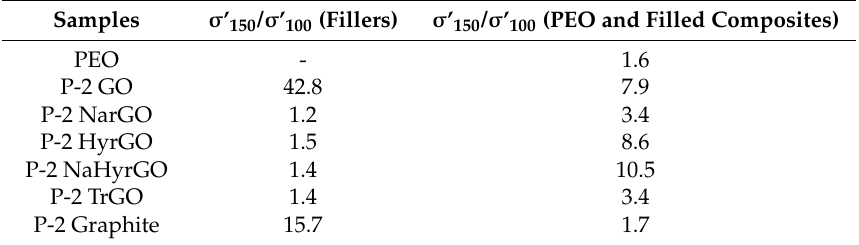
Table 2. Effect of temperature on the electrical conductivity of GO, rGOs and PEO-based